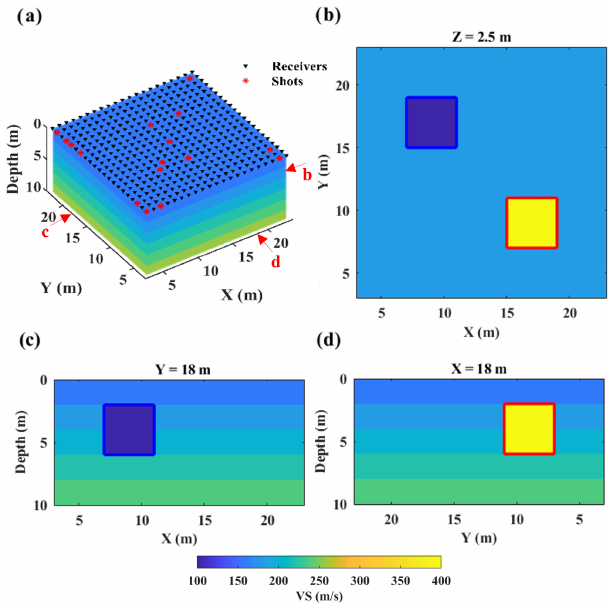
Figure 2. True VS model. (a) 3D view of the model together with the acquisition geometry. The red arrows and letters represent the location of 2D slices in panels (b) – (d) . (b) Horizontal slice at 2.5m depth, (c) vertical slice at Y = 18m, (d) vertical slice at X = 18m. The boundaries of the low-velocity and high-velocity anomalies are superimposed in blue and red, respectively ( X and Y axes do not start from the origin since there is a 3m absorbing boundary at each side of the model in the simulation).